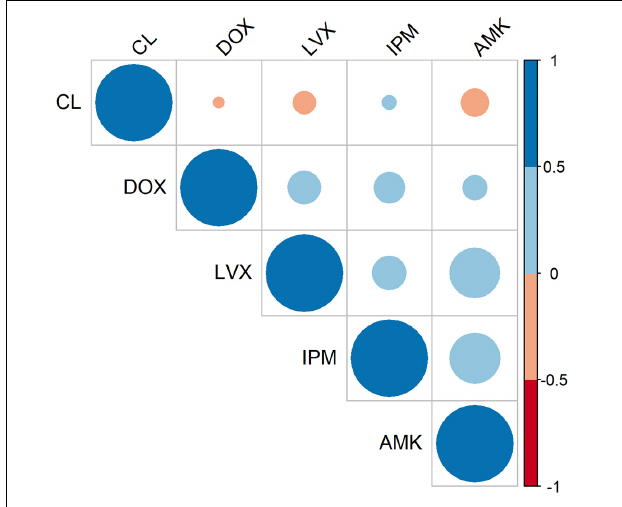
FIGURE 2 | Antibiotic–antibiotic correlations. Correlogram representing correlation coefficients between each pair of antibiotics according to the patterns of susceptibility of the A. baumannii 90 isolates. The color intensity represents Spearman’s rank correlation coefficient ( r s) value (blue tones are positive correlations, and red tones are negative correlations).